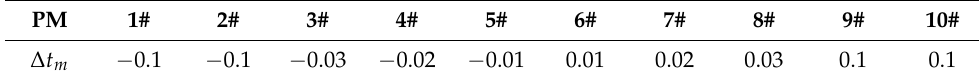
Table 4. The thickness error value of 10 PMs (Unit: mm).